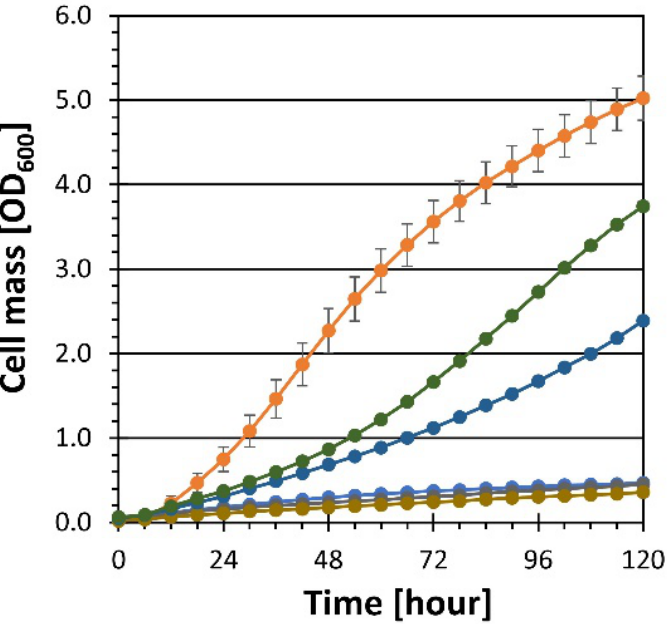
Figure 6. Growth curves for PBS2 and PHO13 deletions in strains expressing the XR/XDH pathway. PBS2 and PHO13 genes were deleted in strain CEN.PK2-1C expressing the S. stipitis XYL1 and XYL2 , and ScXYKS1 genes. YP5X medium was used. Plots are the average values from at least triplicate cultures. Error bars show standard deviations. Scheme 631. (unadapted XI strain), YRH1114 (adapted XI strain), YRH2040 (CEN.PK2-1C with XR/XDH/XK plasmid), YRH2053 (YRH2040 + pbs2 ∆ ), YRH2054 (YRH2040 + pho13 ∆ ), YRH2055 (YRH2040 + pbs2 ∆, pho13 ∆ ). To determine if PHO13 and PBS2 mutations were resposibile for the increased xylose fermentation obserseved with the adapted strain YRH1114 in our previouse study [16], we determined the effect of both single and double deletion of PHO13 and PBS2 in strains expressing either the XI/XK or XR/XDH pathway. Batch fermentations using strains expressing the XI/XK pathway (Figure 7 panels A, C, E, G) were consistent with results from aerobic culture using xylose medium. Single deletion of PHO13 or PBS2 did not increase growth or ethanol production when grown under microaerobic conditions. Deletion of both PHO13 and PBS2 resulted in a fermentation profile that was similar